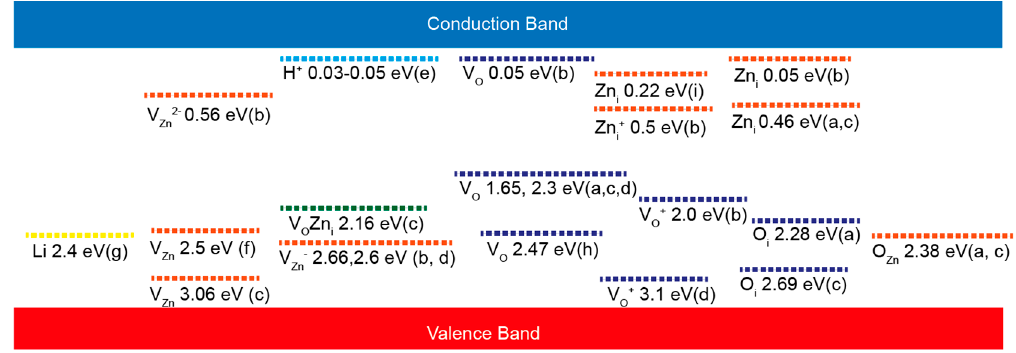
Figure 8. A summary of different defect-related energy levels in the ZnO bandgap reported in the literature by different groups: ( a ) [129]. ( b ). [145]. ( c ). [133]. ( d ). [147]. ( e ). [148]. ( f ). [138] ( g ) [149]. ( h )[146]. and ( i ). [150]. A color code has been used to point out the different defect states, e.g., the Zn defect is represented by orange lines, oxygen defects are presented by a dark violet color, the Li defect is presented as a yellow bar, the hydrogen level is represented by a light-blue bar, and the complex state attributed to the combination of oxygen and zinc defect states is represented by a green color.